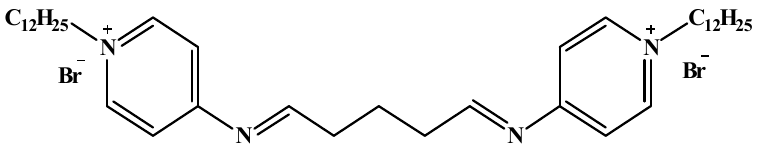
Figure 7. The chemical structure of the synthesized cationic gemini surfactant, 4,4′-(((1E,5E)-pentane-1,5- diylidene)bis(azanylylidene))bis(1-dodecylpyridin -1-ium) bromide [16]. The synthesis had a total yield of 91.3% (for more details see the supplementary materials )